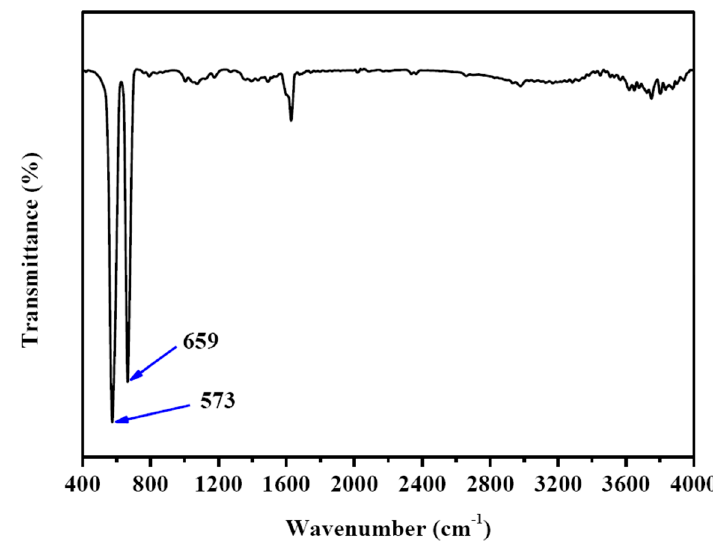
Figure 4. FTIR spectrum of the CuCo 2 O 4 nanoplatelets.